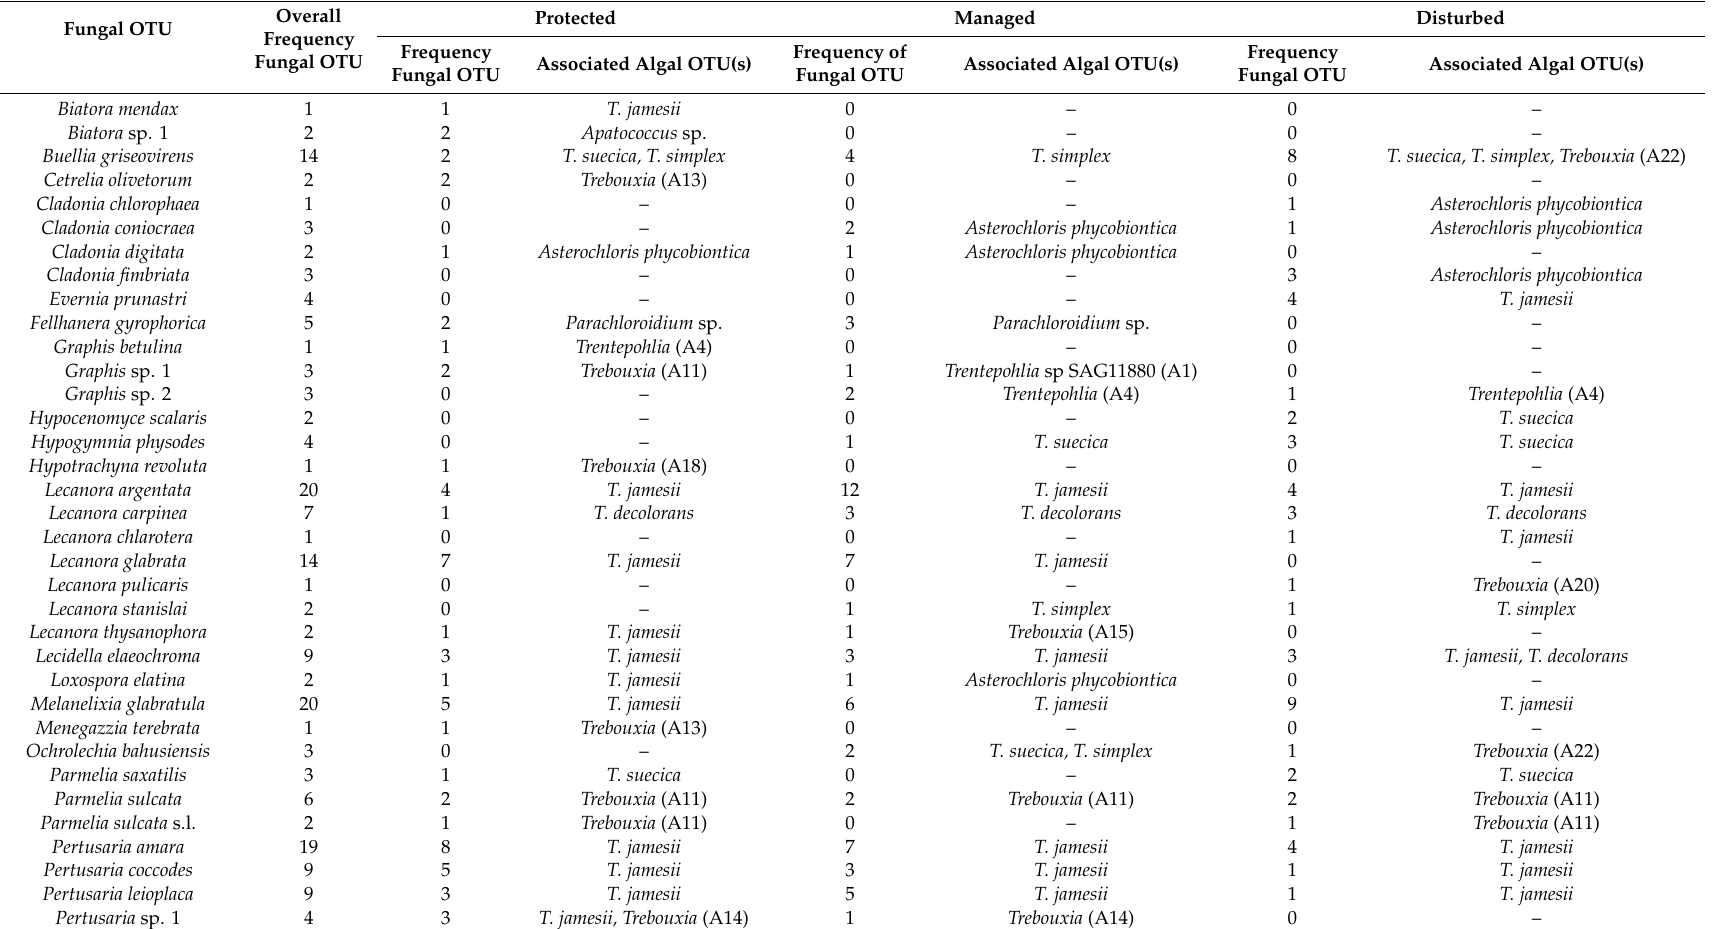
Table 2. Fungal–algal associations of lichens in a protected, a managed, and a disturbed area of Białowie˙za Forest. Overall Protected Fungal OTU Frequency Fungal OTU